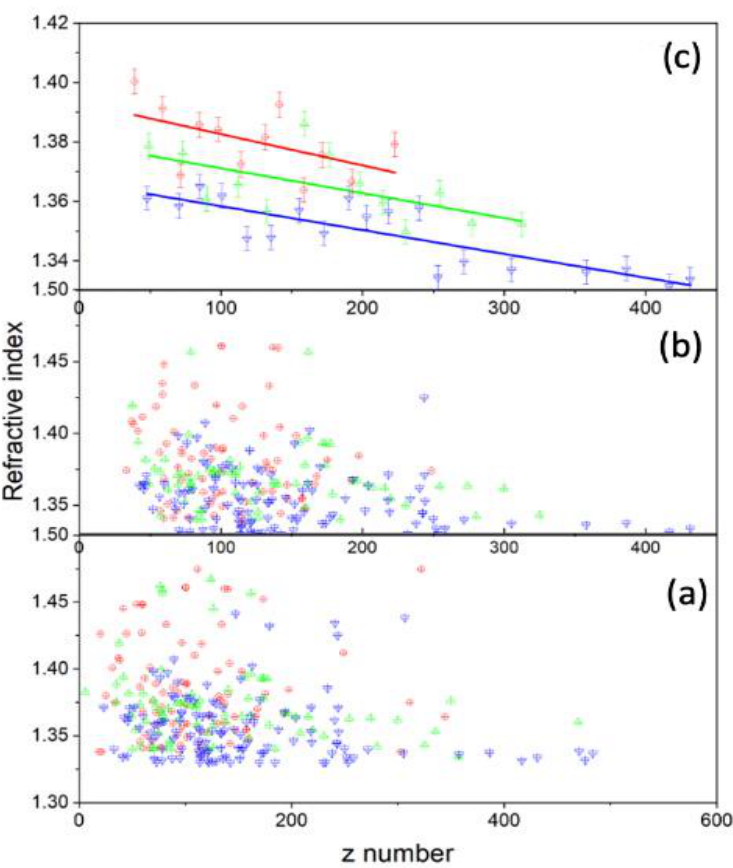
Figure 8. ( a ) The scatter plot shows how the refracted index relates to the charge. ( b ) This is after the reduced method was performed on the data. ( c ) The data after further reduction was carried out and then fitted. There is a negative correlation between charge and refracted